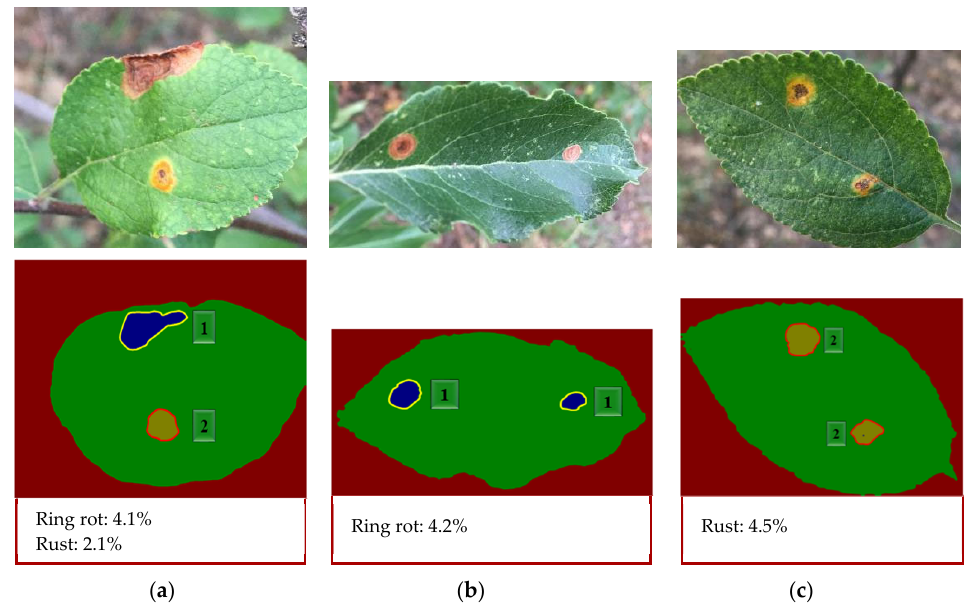
Figure 9. The segmentation effect of different diseases: ( a ) ring rot and rust of apple leaf; ( b ) ring rot of apple leaf; ( c ) rust of apple leaf.